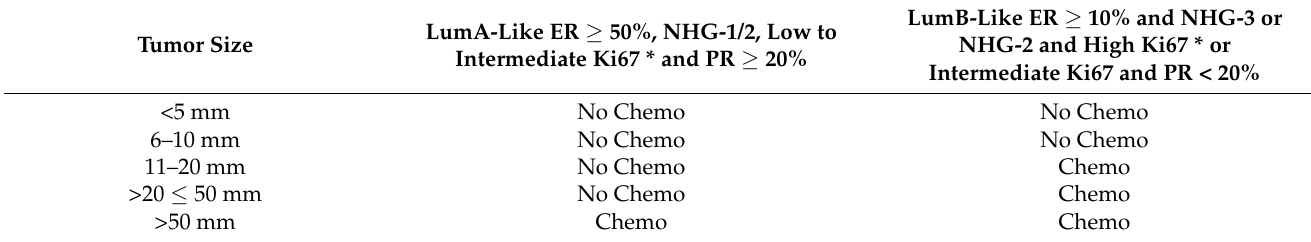
Table 2. Indication for adjuvant chemotherapy according to Swedish national guidelines from 2018 and adapted regionally. NHG; Nottingham Histologic Grade. * Pathology lab specific Ki67 limits; Karolinska, Södersjukhuset, St:Göran hospital low 0–14%, intermediate 15–22%, high 23–100%; Jönköping, low 0–11%, intermediate 12–21%, high 22–100%; Akademiska hospital, low 0–14%, intermediate 15–23%, high